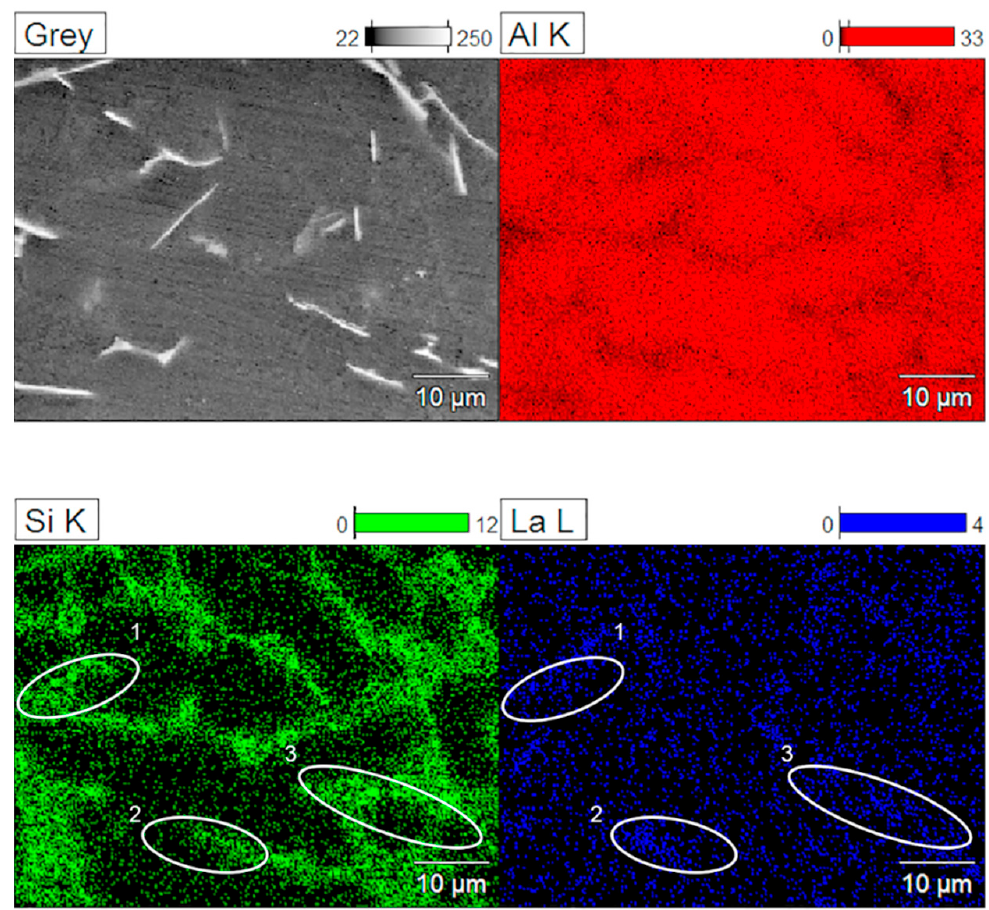
Figure 5. EDS analysis of AlSi5Cu1Mg + 0.9 wt % La alloy.